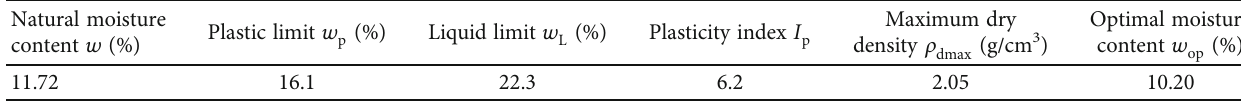
Table 1: Physical properties of soil samples.